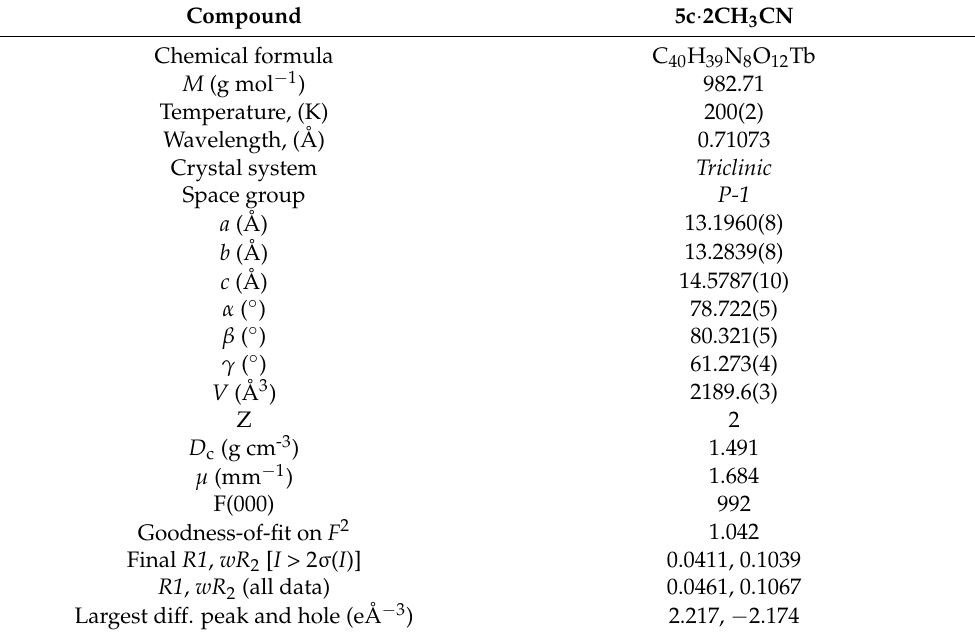
Table 1. Crystallographic data, details of data collection and structure refinement parameters for